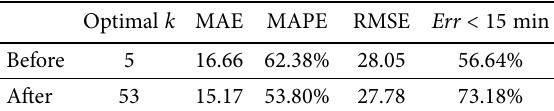
Table 3. Prediction results before and after log transformation